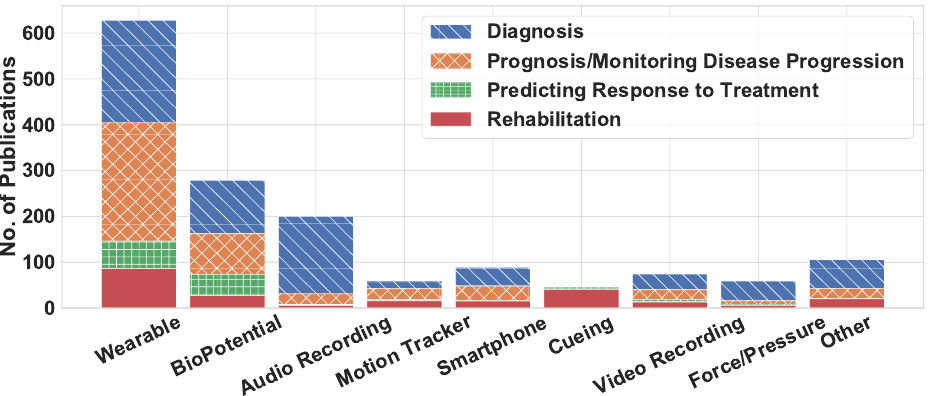
Figure 13. The distribution of articles published between 2008 and 2021 related to the assessment of Parkinson’s disease using wearable and mobile